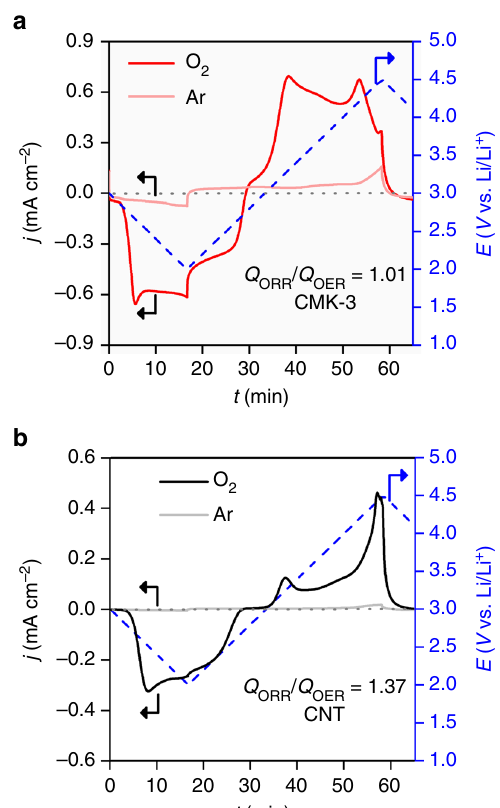
Fig. 6 Cyclic voltammetry. a CMK-3 and b CNT electrodes at a sweeping rate of 1 mV s – 1 in bulk electrolysis cell with 0.5 M LiTFSI/tetraglyme. The blue dashed lines indicates input potential curve. The light and dark solid curves indicate Ar (O 2 -free) and O 2 environment,